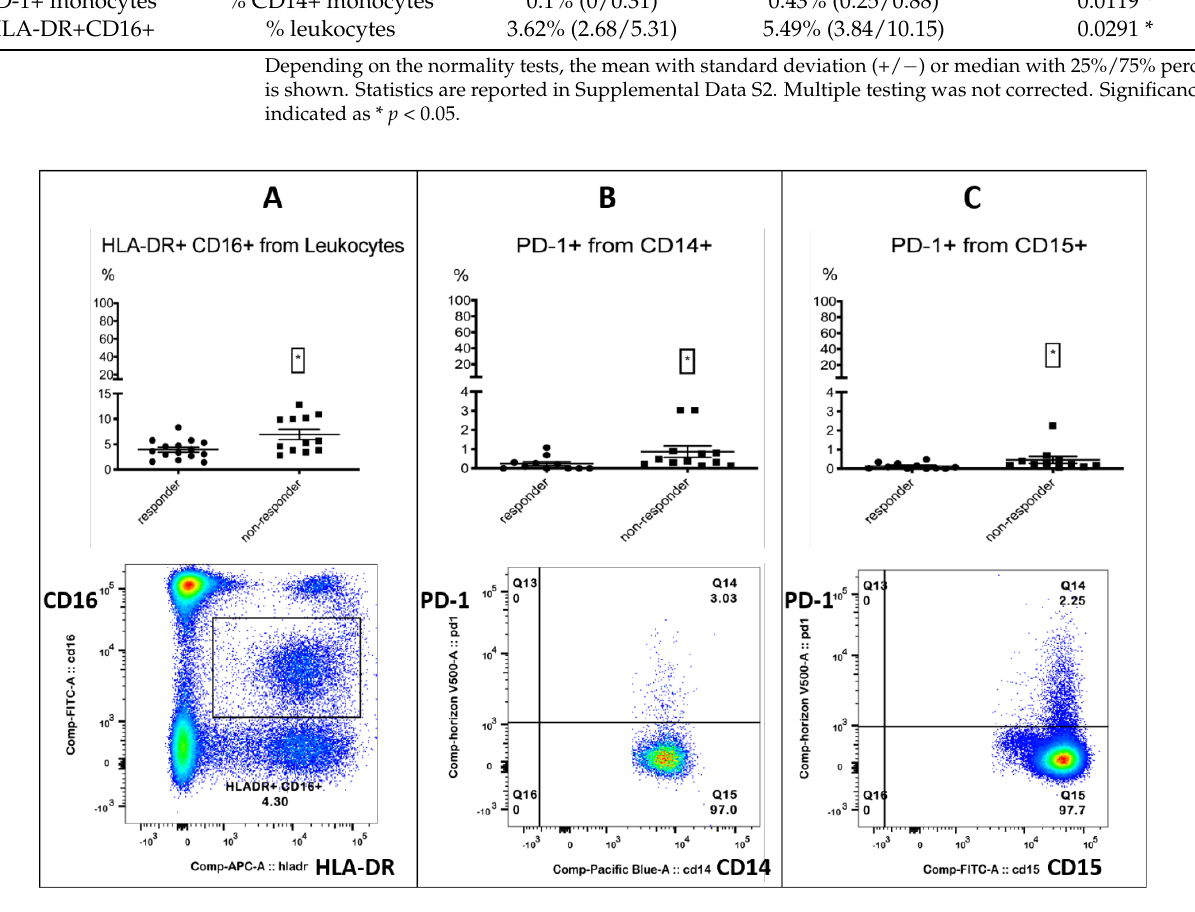
Figure 1. Myeloid cells. Three myeloid subsets were associated with treatment failure. The top row shows the % positive from the parent population for responders and non-responders. Left column: responders; right column: non-responders. The bottom row shows the FACS gating. Left ( A ) : HLA- DR+ CD16+ (medium) monocytes % from leukocytes. Middle ( B ) : PD-1+ monocytes % from CD14+ monocytes. Right ( C ) : PD-1+ granulocytes % from CD15+ granulocytes. Significance was indicated as * p <